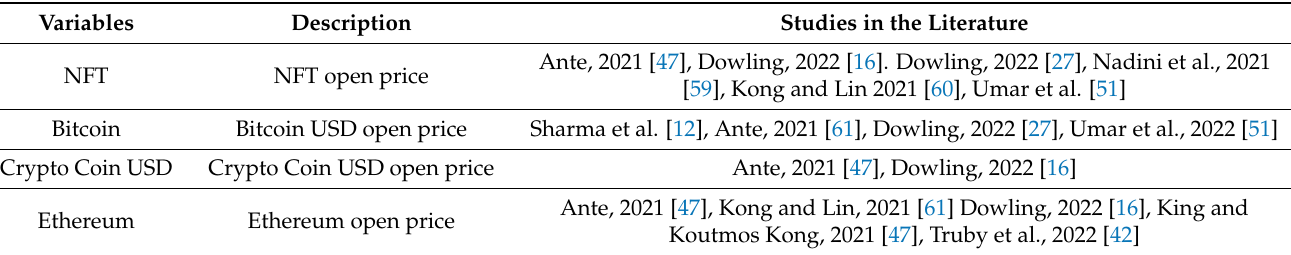
Table 1. Variables